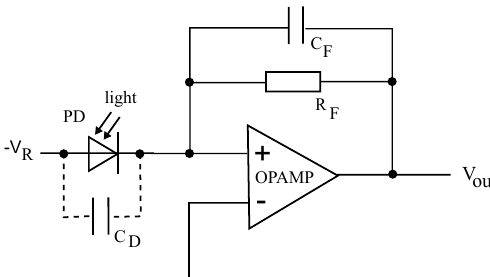
Figure 7. Drawing shows a basic TIA with photodetector. R F and C F are the feedback resistor and capacitor to the operational amplifier. C D is the capacitance of the photodetector, V R the reverse voltage to reduce this capacitance and V out is the output